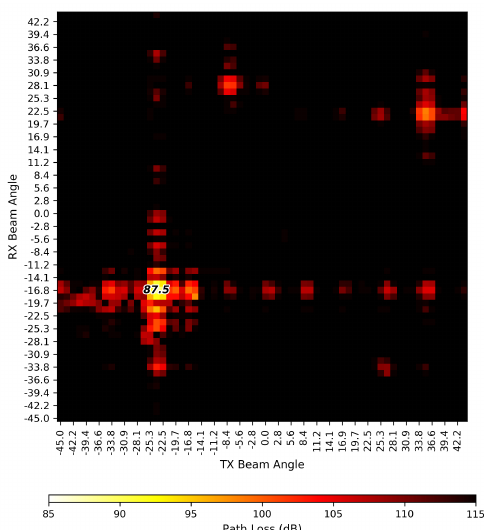
Figure 7. Angular path loss profile measured with Terragraph platform for link NLOS1 with distance 4.7